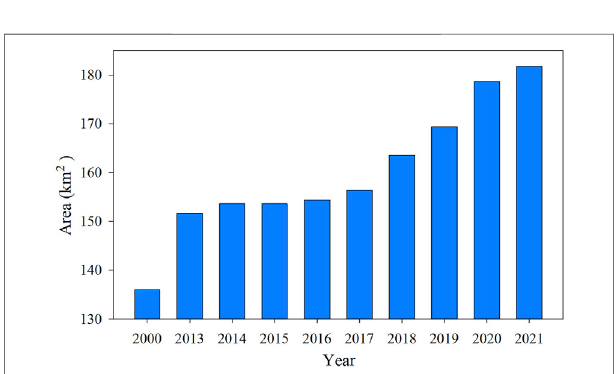
FIGURE 6 | Annual area variation of Tuosu Lake in 2000 –